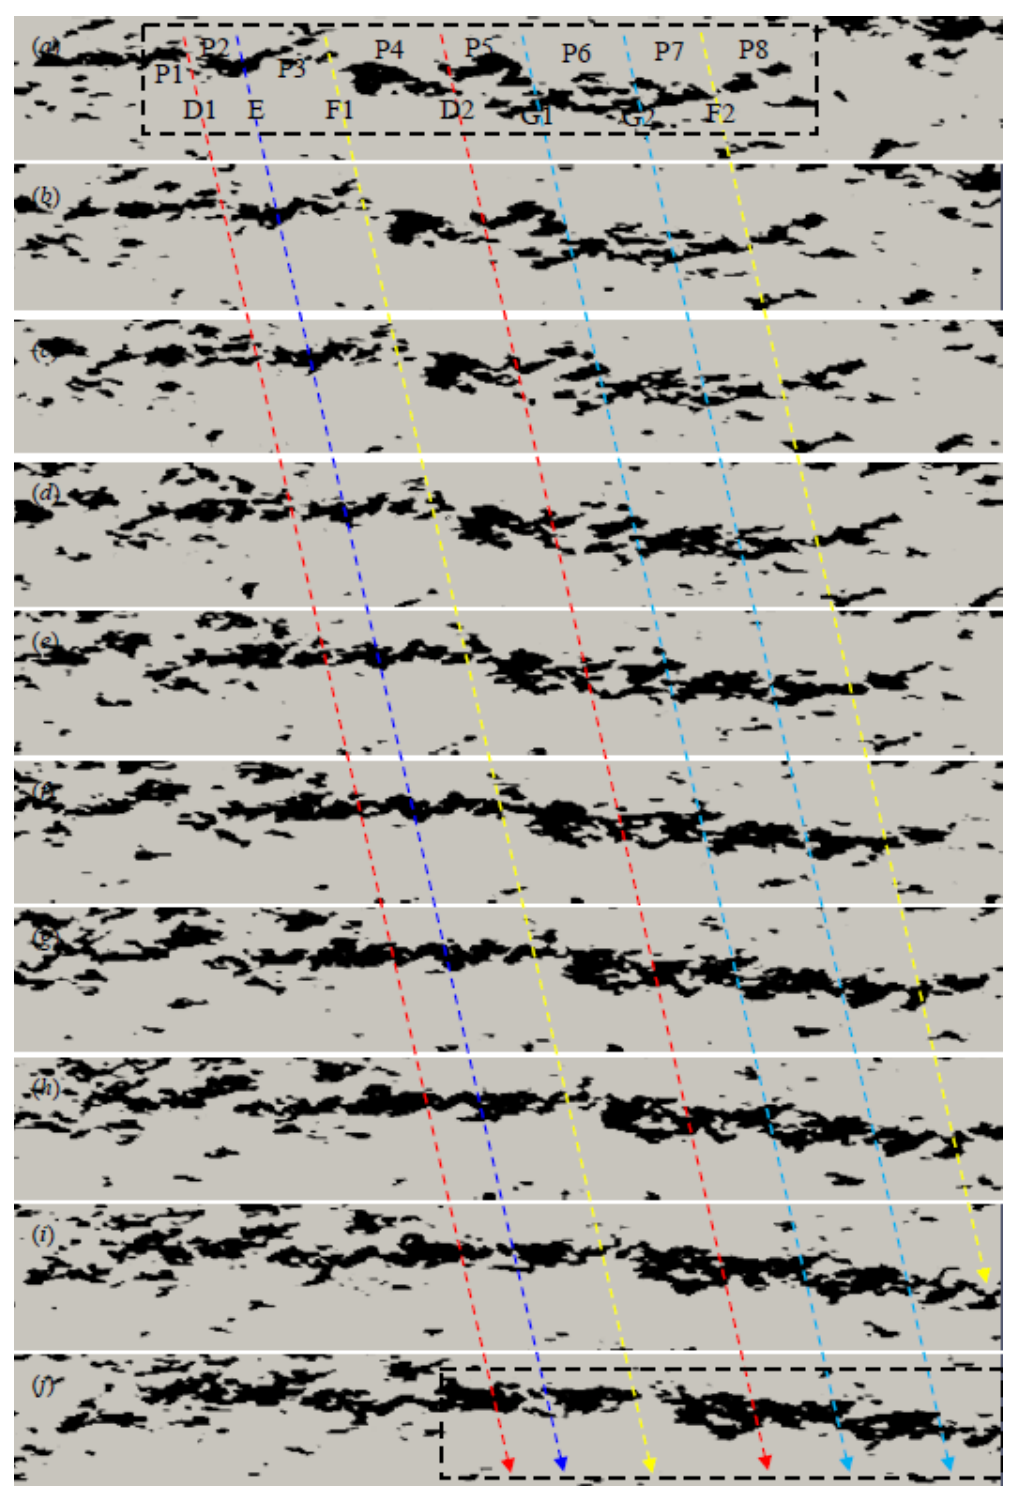
Figure 18. Time evolution of the instantaneous fields at a height of 30 m in xy plane. The dashed line D1, D2 are added to show the growth of the VLSMs, dashed line E is added to show the extinction of the VLSMs, F1, F2 are added to show the growth first then extinction of the VLSMs and G1, G2 are added to show the extinction first then growth of the VLSMs. P-number represents the different part of VLSMs of Figure 18f. Subfigures a to j represent the time evolution of flow field.